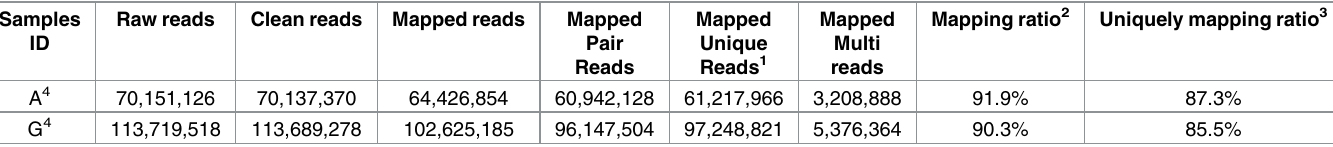
Table 1. Characteristics of the reads from pectoral libraries obtained from 2 breeds of